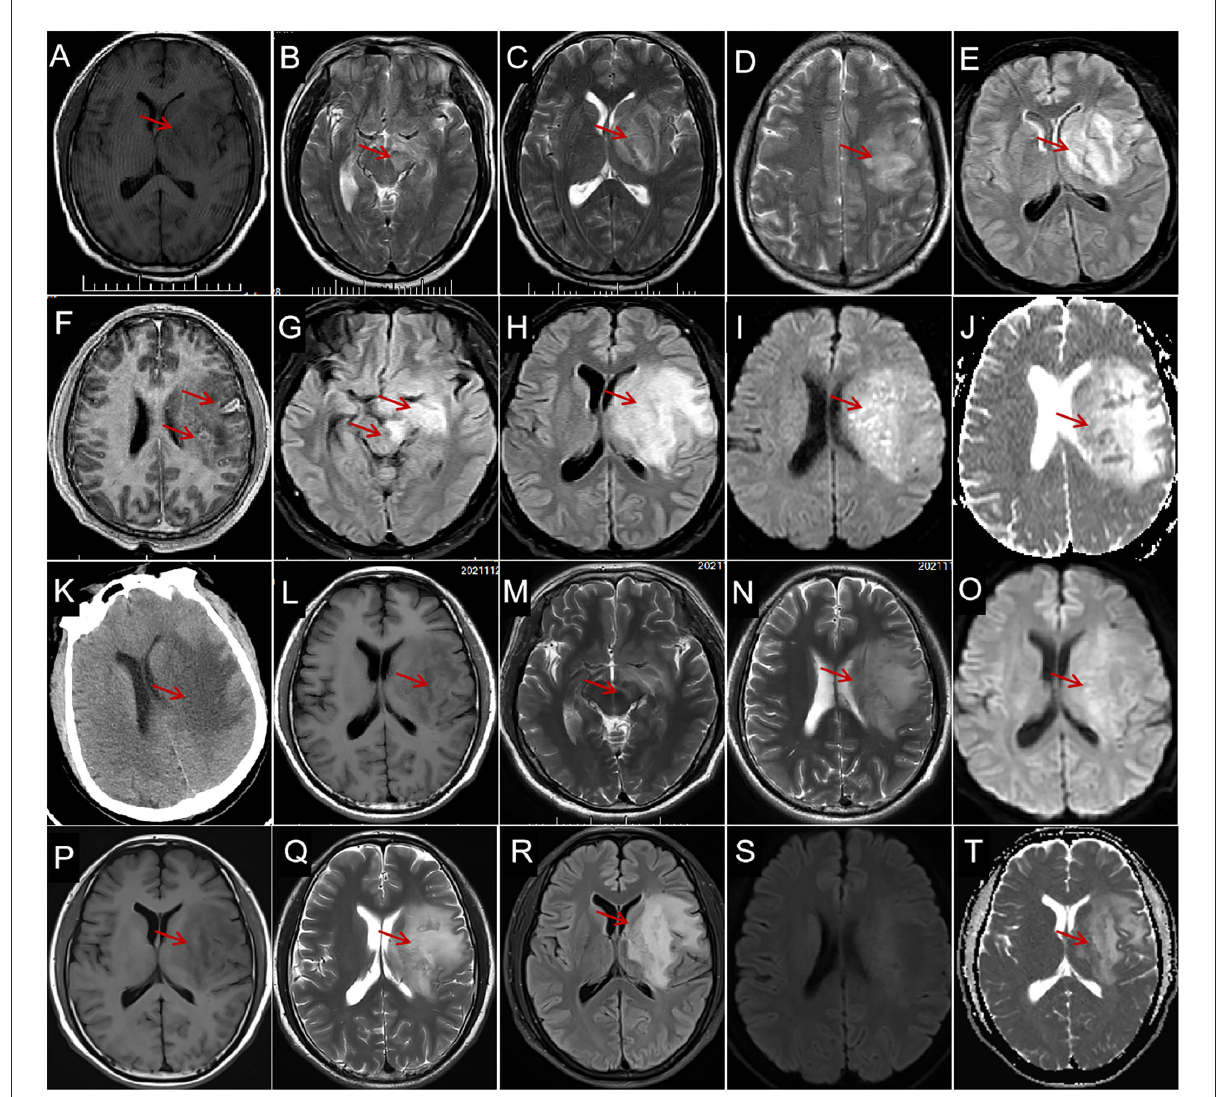
FIGURE1 Characteristics and evolution of lesions on brain magnetic resonance imaging (MRI) and computed tomography (CT). (A) Brain MRI on day 1 shows a large hypointensity (arrows) in the left basal ganglia and the temporal lobe on axial T1-weighted imaging (WI); a hyperintense region (arrows) in the left midbrain (B) , basal ganglia (C) , and temporal-parietal lobe (D) on T2-WI and fluid-attenuated inversion recovery [FLAIR (E) ] with space-occupying effect; and individual, small, arc-shaped, ring-shaped lesions are enhanced [ (F) , arrows]. The MRI on day 5 shows extensive hyperintense lesions enlarged (arrows) in the left midbrain, hippocampus [ (G) , arrows], basal ganglia, and temporal lobe [ (H) , arrows] on FLAIR, diffusion-weighted imaging [DWI (I) , arrow], and apparent diffusion coefficient [ADC (J) , arrow]. CT on day 6 reveals extensive, finger-shaped, low-density areas with space-occupying effects in the left basal ganglia and semioval center [ (K) , arrow]. MRI on day 34 shows slight hypointensity on T1-WI [ (L) , arrow], slight hyperintensity on T2-WI [ (M,N) , arrows], and DWI [ (O) , arrow], and the space-occupying effect obviously improved. Magnetic resonance imaging on the 25th day after discharge shows hypointensity on T1-WI [ (P) , arrow], hyperintensity on T2-WI [ (Q) , arrow], FLAIR [ (R) , arrow] ADC [ (S) , arrow], and without diffusion restriction on DWI (T)